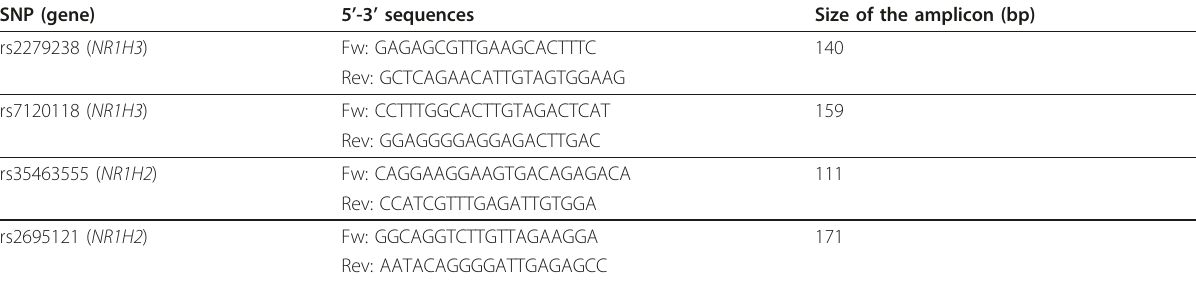
Table 1 Sequence primers used for high-resolution melting curve analyses SNP (gene) 5 ’ -3 ’